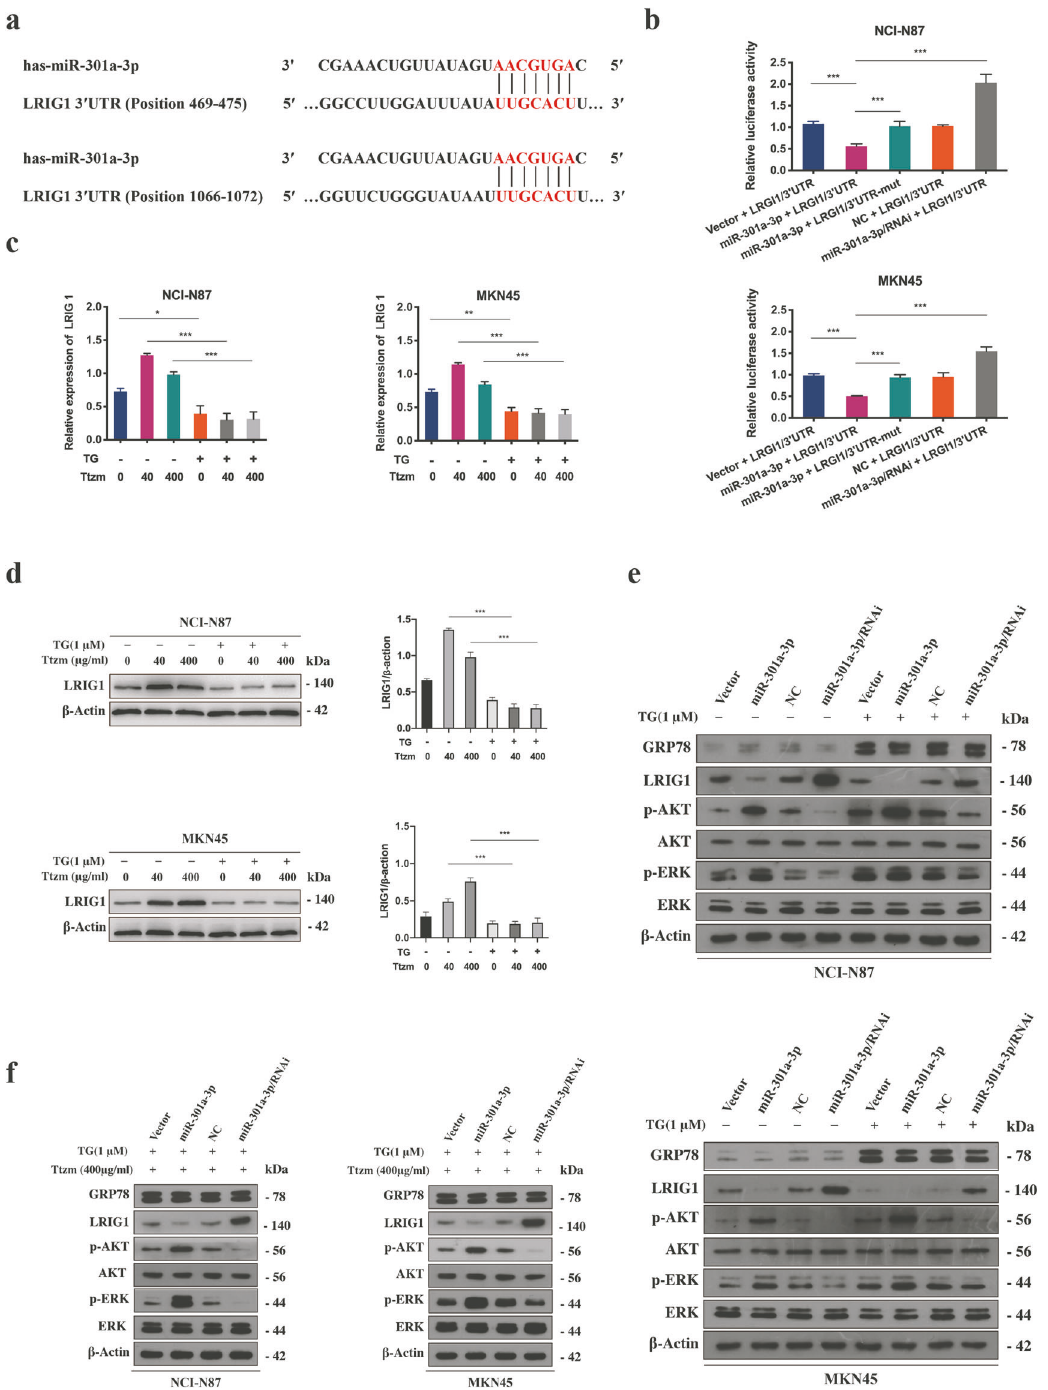
Fig. 3 miR-301a-3p mediated trastuzumab resistance by downregulating LRIG1 expression via directly targeting its 3 ′ -UTR in ER stressed GC cells. a The bioinformatics analyses of TargrtScan7.1 and miRDB databases indicated that the 3 ′ -UTR sequence of LRIG1 mRNA contained two binding sites of miR-301a-3p at nucleotide positions of 469-475 and 1066-1072. b The miR-301a-3p mimics, or NC and the luciferase reporter plasmids containing wide type or mutant 3 ′ -UTR region of LRIG1 were co-transfected into NCI-N87 and MKN45 cells. Relative luciferase activity was then detected. ( n = 3). c qRT-PCR analysis for the LRIG1 mRNA in NCI-N87 and MKN45 cells treated with or without 1 μ M TG for 12 h followed by 40 or 400 μ g/ml trastuzumab treatment for 72 h ( n = 3). d Representative western blot and quanti fi cation for LRIG1 in NCI-N87 and MKN45 cells treated with or without 1 μ M TG for 12 h following by 40 or 400 μ g/ml trastuzumab treatment for 72 h. e The indicated proteins of NCI-N87 and MKN45 cells, which were stably transfected with miR-301a-3p or control and treated with or without 1 μ M TG for 12 h were detected by western blot. f The indicated proteins of NCI-N87 and MKN45 cells, which were stably transfected with miR-301a- 3p or control and treated with 1 μ M TG for 12 h followed by 400 μ g/ml trastuzumab treatment for 72 h were detected by western blot. Statistical analysis was performed by Student ’ s t -test, error bars indicate SD (* p < 0.05, ** p < 0.01, *** p <